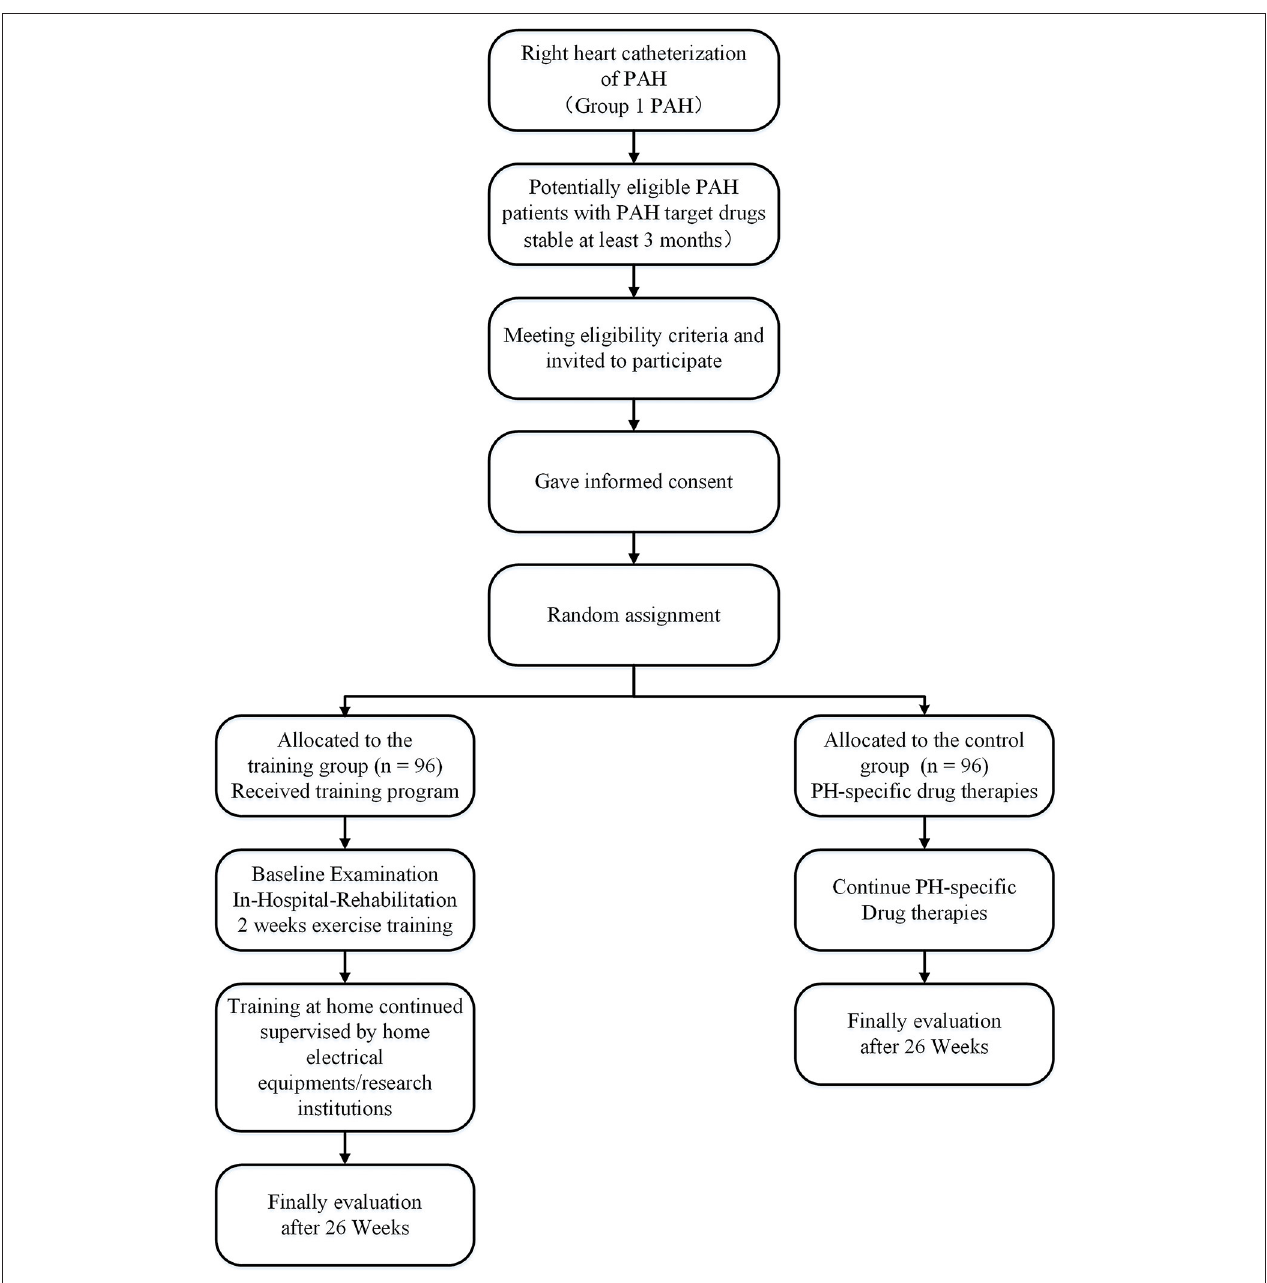
FIGURE 1 | Flow diagram of study recruitment and randomization.